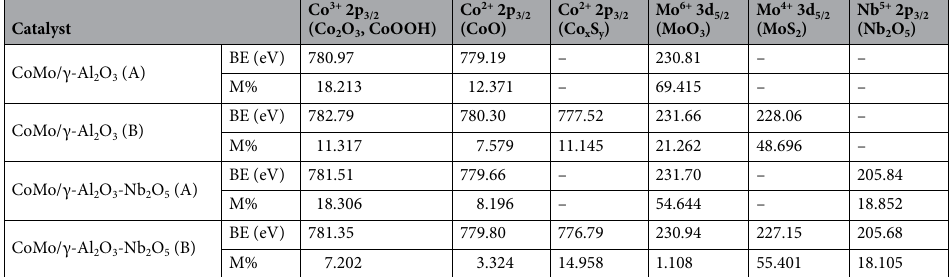
sulphidation also the Co 2p 3/2 peak at 776.79 eV, corresponding to metallic cobalt. The peak at 205.86 eV was characteristic to Nb 3d According to our results, Co 2+ and Mo 4+ species are present in the sulfide form on both catalysts surfaces. In addition, there are also found oxidic species arising from incomplete reduction and sulphidation. The ratios between doublet components line widths were set between 1 and 1.1. 32 . The theoretical mass percentage of Co, Mo and Nb reported to the total metal species (Co + Mo or Co + Mo + Nb), are as follow: for CoMo/γ-Al 2 O 3 catalyst: Co (33.33%) and Mo (66.66%) and for CoMo/γ-